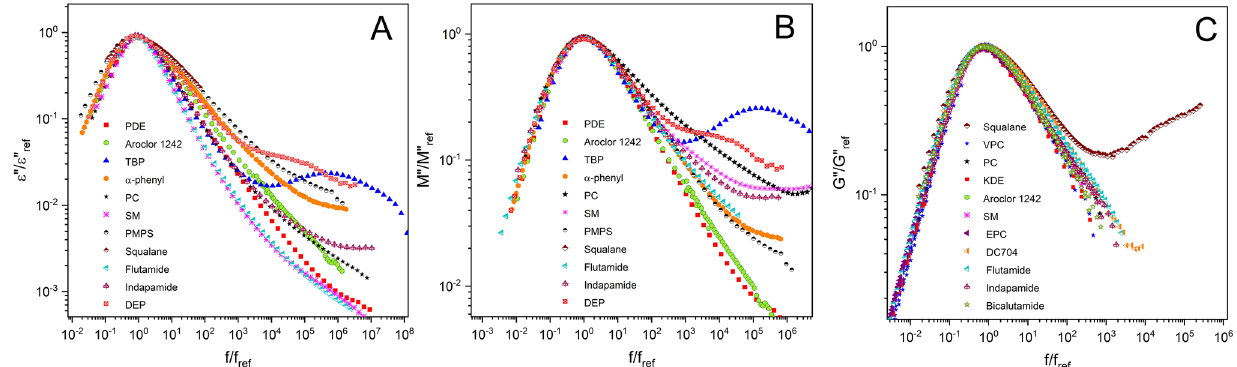
Figure 9. Dielectric ( A,B ) and mechanical ( C ) data of polar and weekly polar glass-formers. The data of PC, flutamide, indapamide, DEP, bicalutamide, EPC and VPC were obtained in this